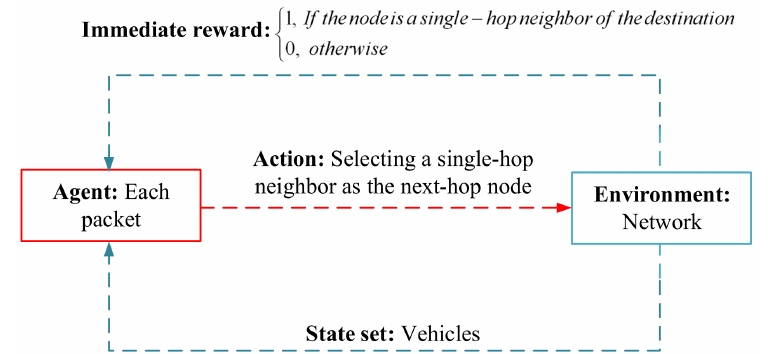
Figure 11. Learning structure in